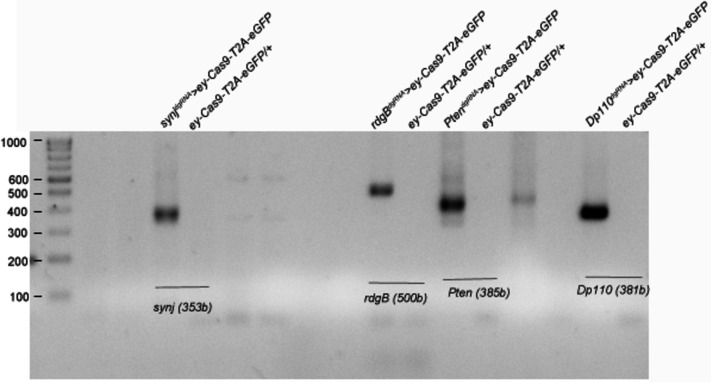
Genomic deletion obtained in CRISPR tissue-specific KOs is comparable irrespective of the presence or absence of phenotype.Genomic PCR is done using heads of the flies from appropriate genotypes as indicated. dgRNA targeting synj and rdgB were chosen as examples of genes that did not show expected phenotypes, while dgRNA targeting Pten and Pi3K92E (Dp110) were chosen as examples of genes that showed phenotypes when expressed in tissue-specific manner using ey-Gal4;UAS-Cas9-T2A-eGFP. Expected deletion band size are seen in heads of deletion genotype as indicated in parenthesis. Expected larger sized wild-type bands are missing in controls because of large size of the genomic region (Primers used are listed in Supplementary file 2).